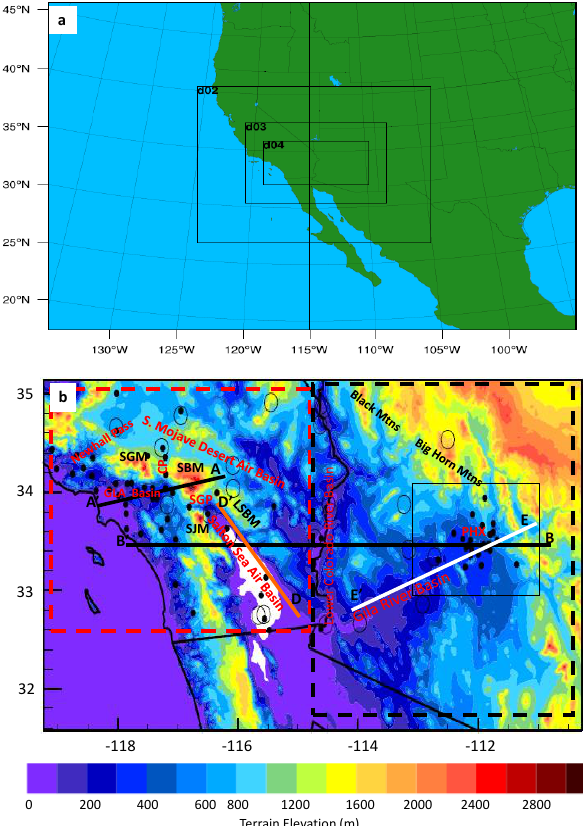
Figure 1. (a) 4-nested model domains–D01 to D04, from the largest rectangle box to the smallest rectangle box. (b) Innermost domain terrain elevation (m). Black dots indicate the locations of CO, NO x , and/or O 3 observation sites. Circles represent surface wind obser- vation sites. Red-dashed-line box shows the southern California and black-dashed-line box stands for southern and central Arizona. SGM stands for the San Gabriel Mountains; SBM indicates the San Bernardino Mountains; LSBM indicates the Little San Bernardino Mountains; SJM represents the San Jacinto Mountains. SGP stands for the San Gorgonio Pass, between SBM to the north and SJM to the south. CP represents the Cajon Pass between SGM to the west and SBM to the east. PHX stands for Phoenix metropolitan area. Lines A’A, B’B, D’D, and E’E are cross-section locations and are discussed in text and Figs. 8, 10, 13 and 14, respectively.